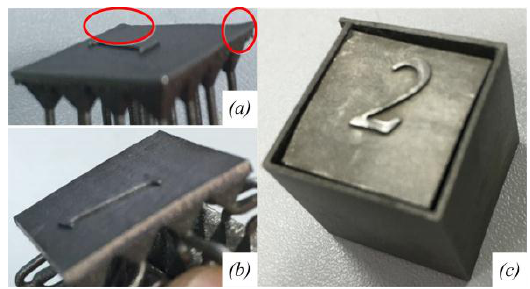
Figure 3. Large curling of direct manufacturing candidate ( a ), small curling of sample fabricated with additional skin after wire-electrode cutting ( b ) and sample fabricated with additional skin ( c ).